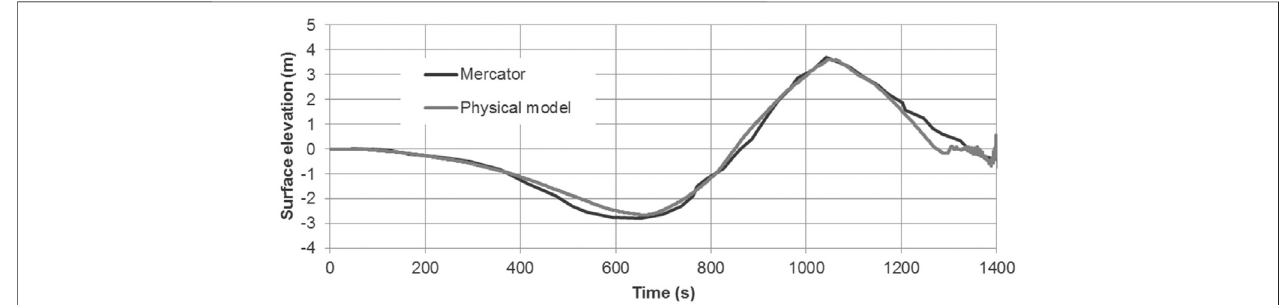
FIGURE 4 | Mercator time series at 1:50 scale with measurements in improved fi rst generation Tsunami Simulator.